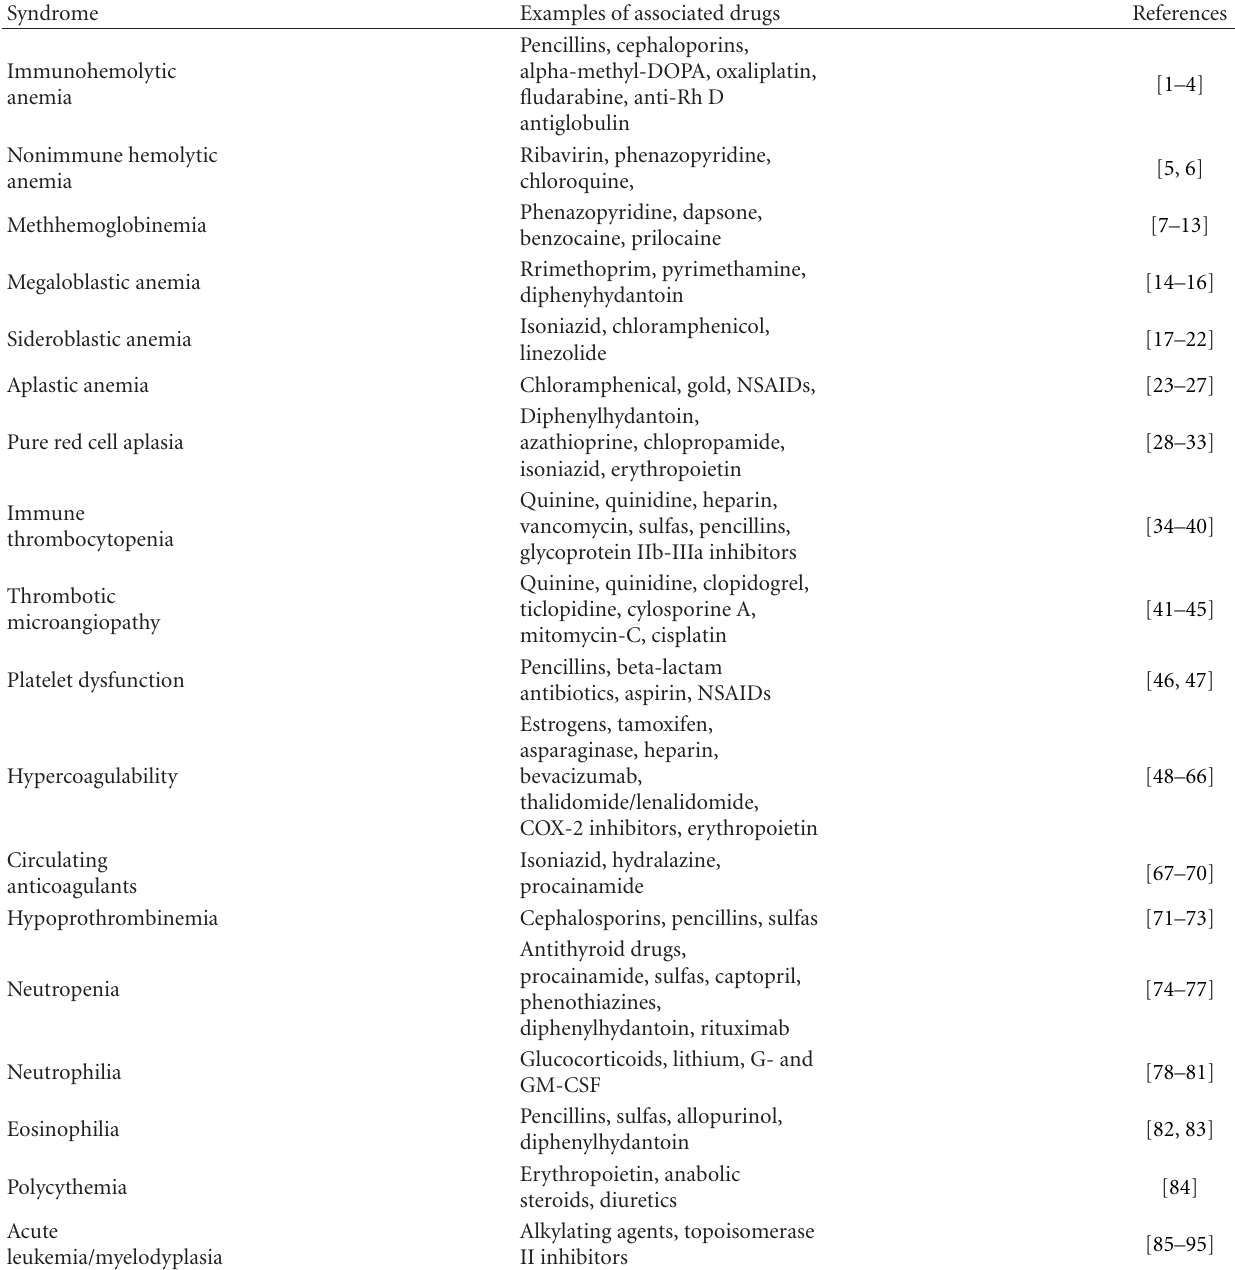
Table 1: Drug induced hematologic